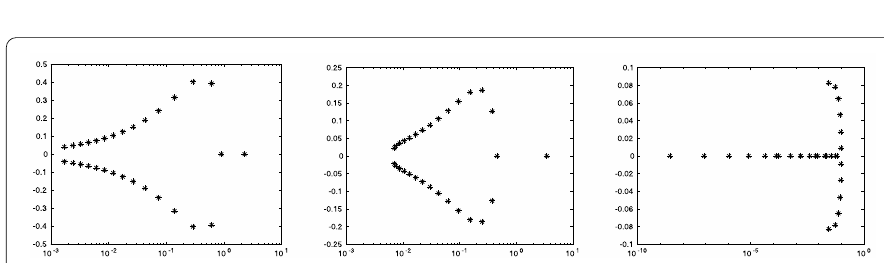
Figure 6 Eigenvalues of the matrix U n , n = 30, for selected Jacobi